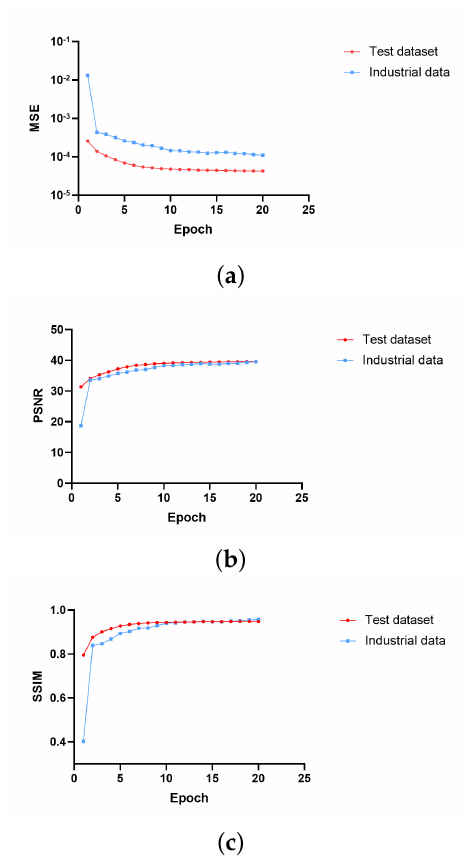
Figure 14. Metrics changes in training process. ( a ) MSE; ( b ) PSNR; ( c )